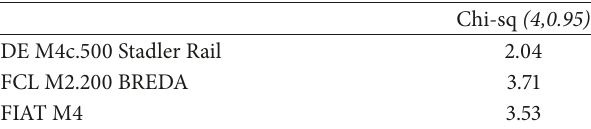
Table 7: Chi-square test.